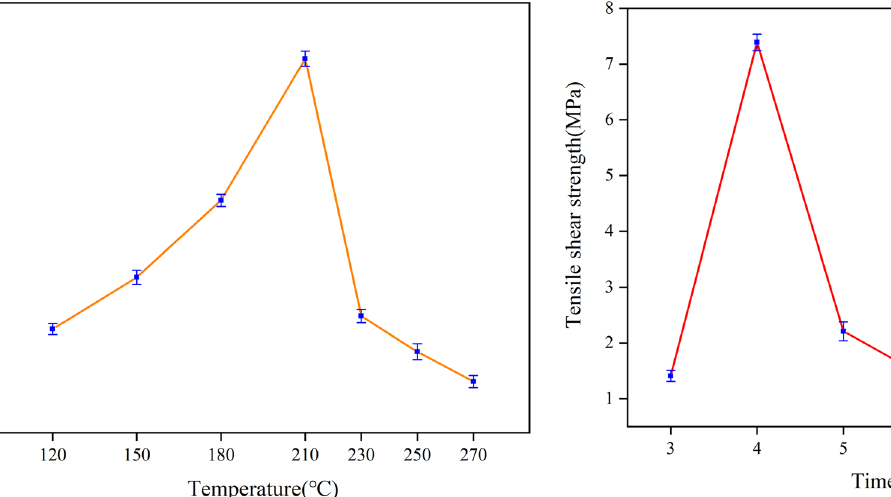
Figure 9: Tensile shear strength of E 2 with di ff erent curing time.